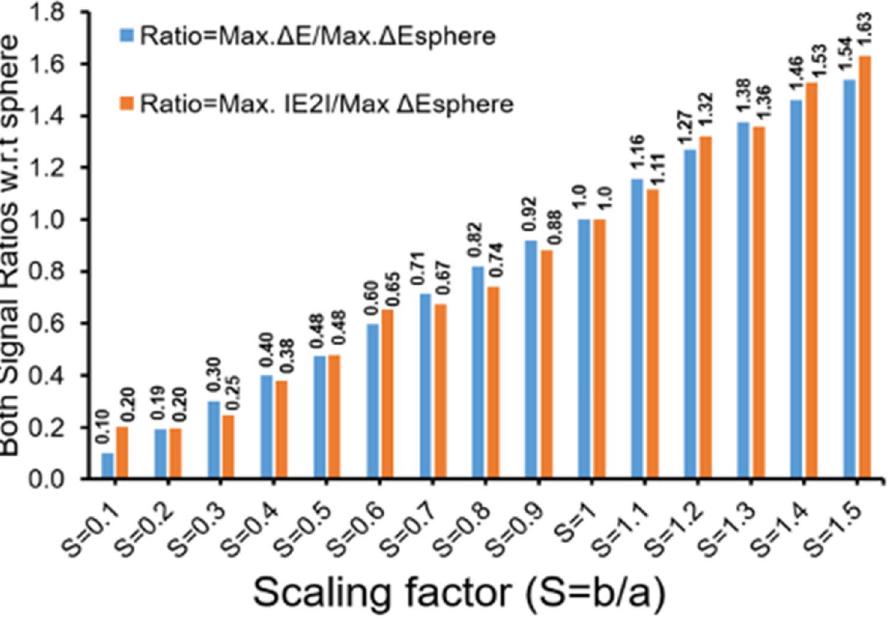
Figure 5. Maximum of signal ratios (ΔE and │ E 2 │ ) with respect to sphere (S = b/a = 1) illustrates a gradual change from spherical to non-spherical shape particle. Scaling factor (S = b/a) increases from 0.1 to